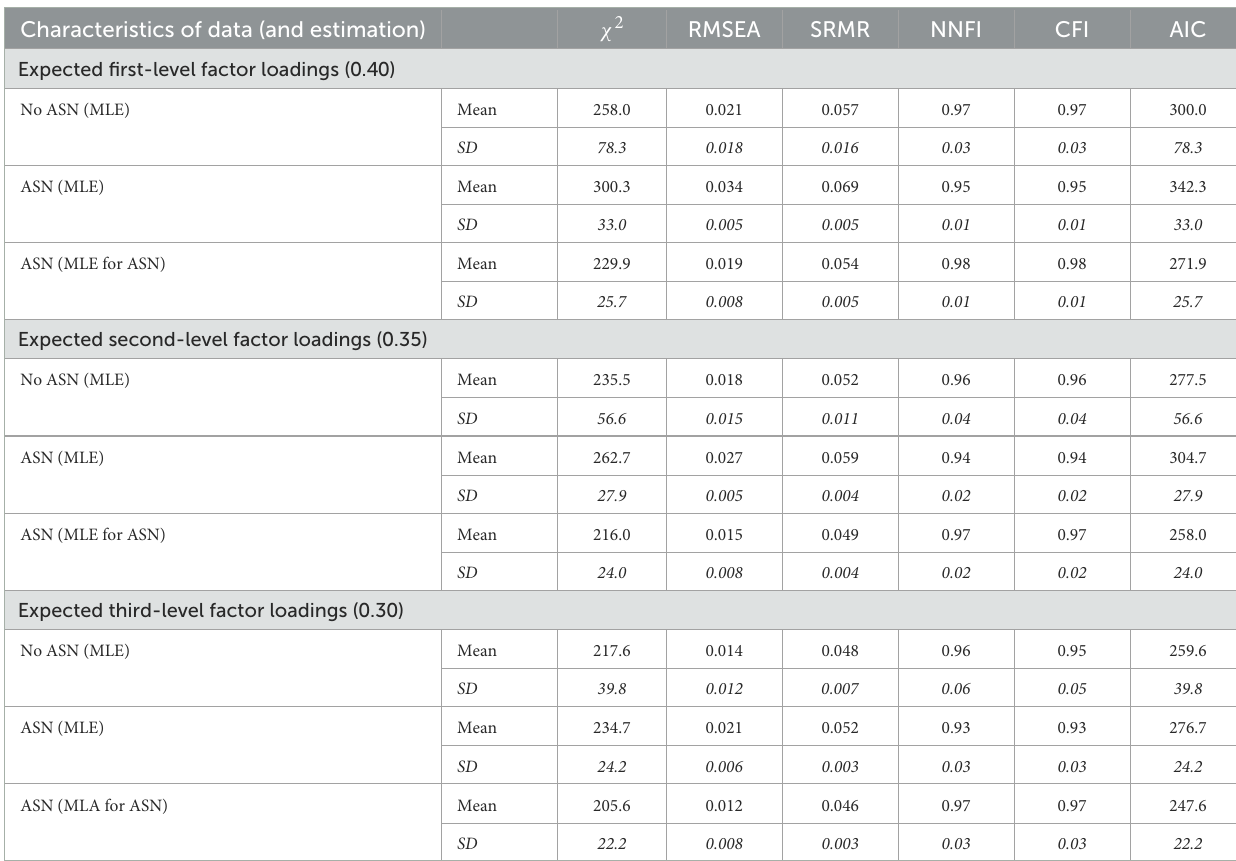
TABLE 1 Mean fit results and SDs (in italics) observed in investigating data showing (no) asymmetric non-normality (ASN) by one-factor models using regular MLE and MLE for ASN ( N = 500). Characteristics of data (and estimation) χ 2 RMSEA SRMR NNFI CFI AIC Expected first-level factor loadings